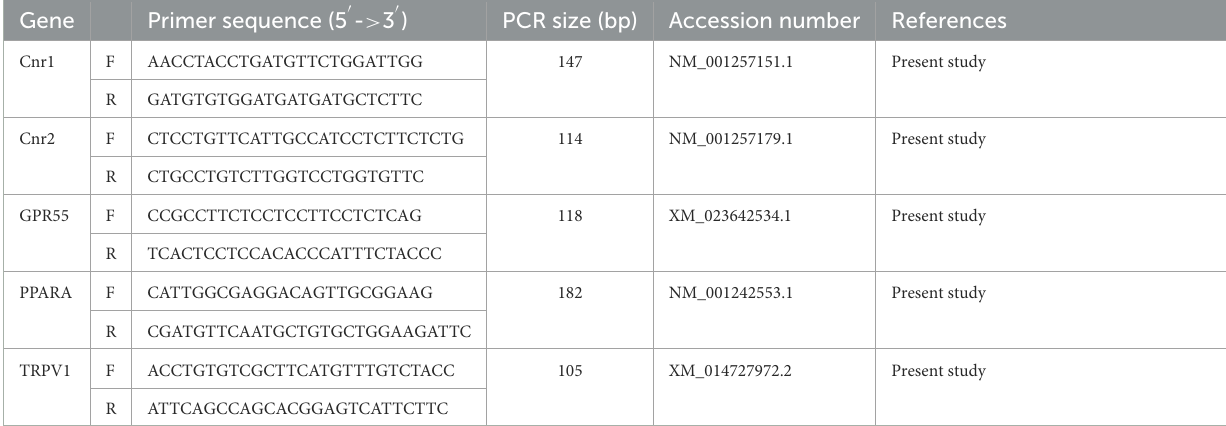
TABLE 1 Primer sequence used for quantitative real time PCR analysis. Gene